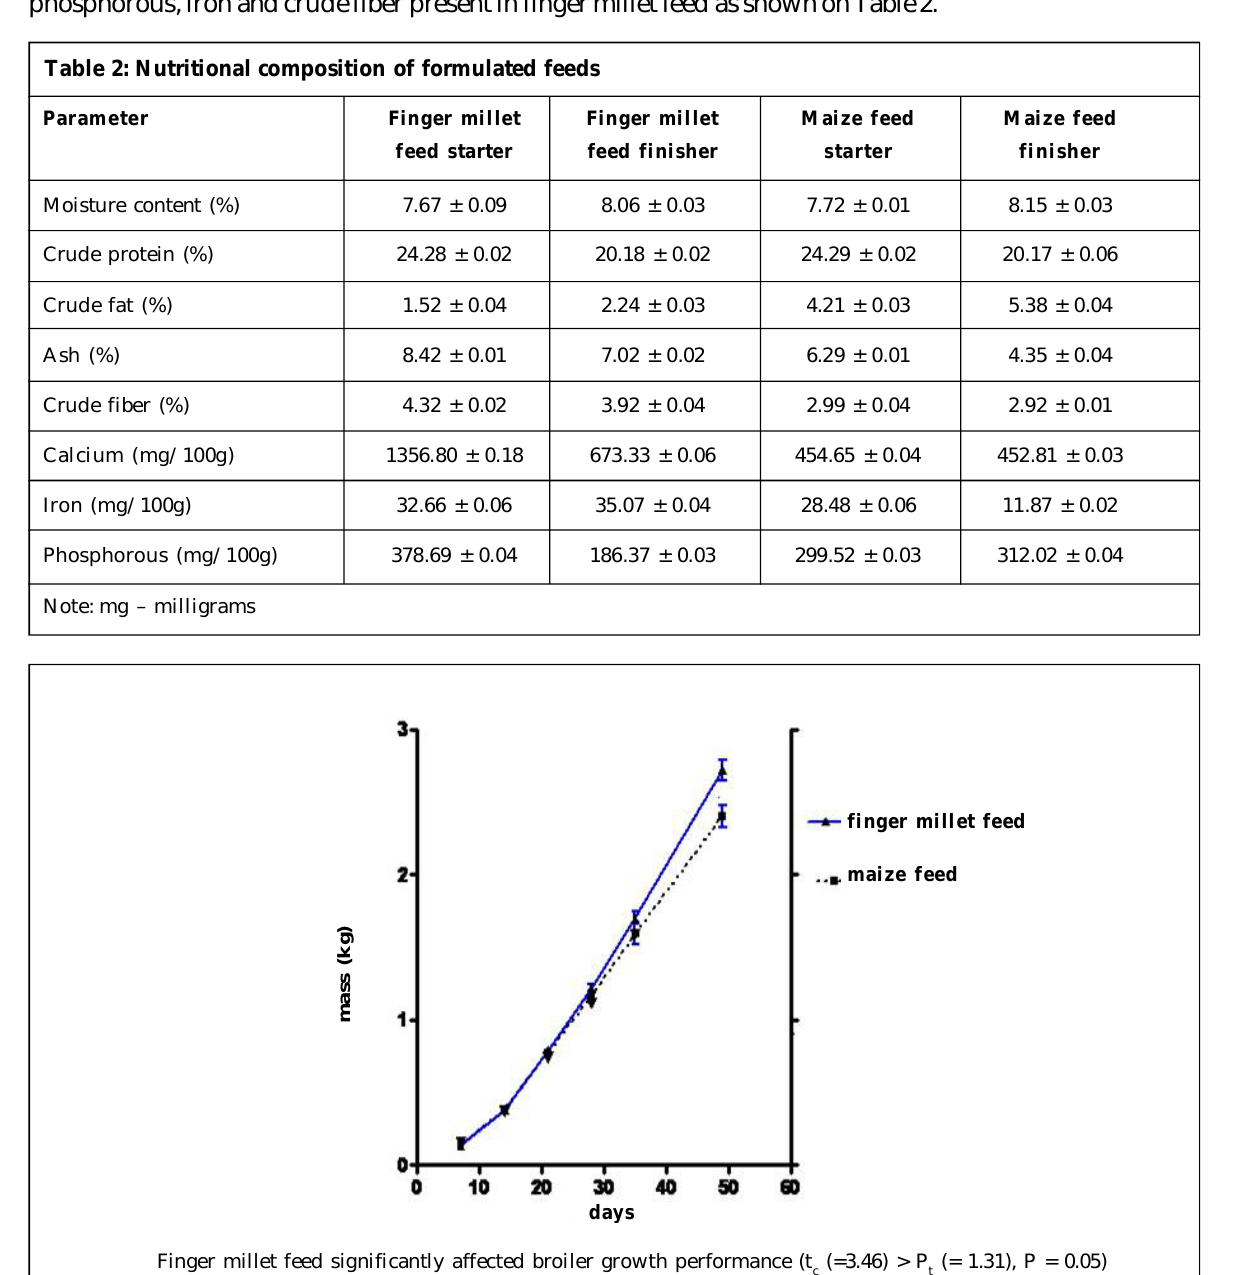
Figure 4: Mass – time curves of broilers fed on finger millet feed and maize